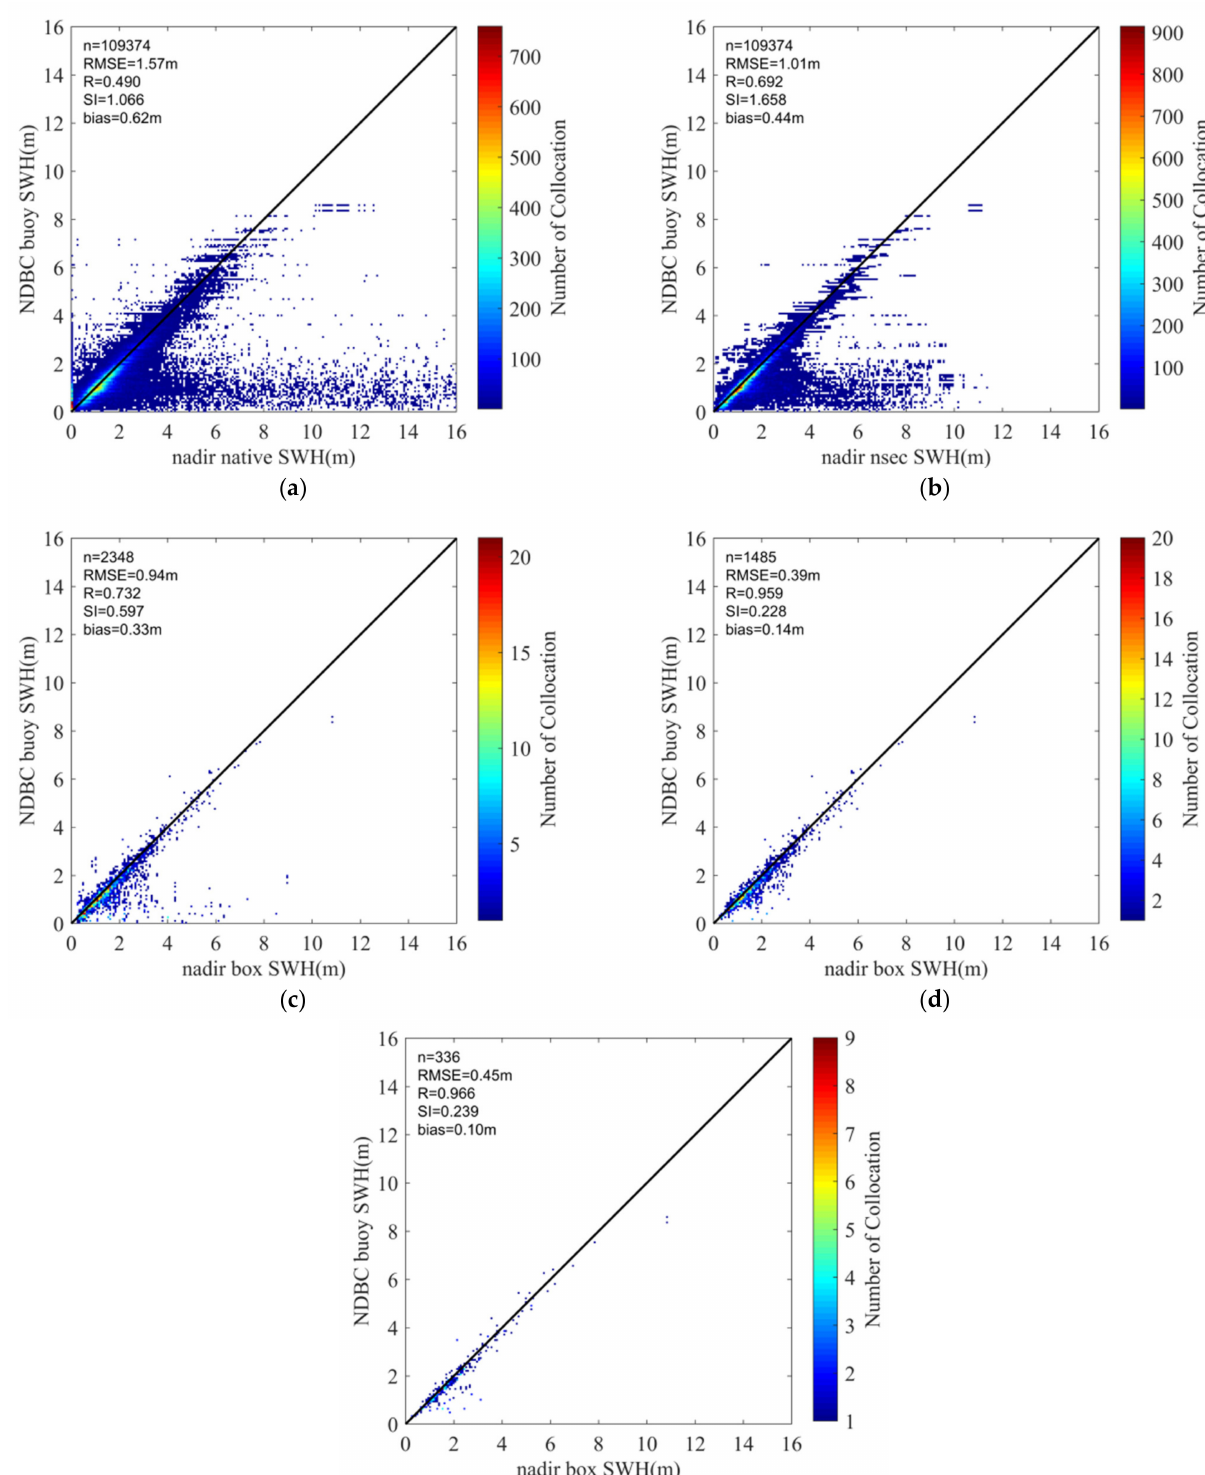
Figure 4. Comparison between nadir SWH and NDBC buoy data: ( a ) native data, ( b ) nsec data, ( c ) box data without quality control, ( d ) box data with quality control index of 100% and ( e ) box data with quality control index of more than